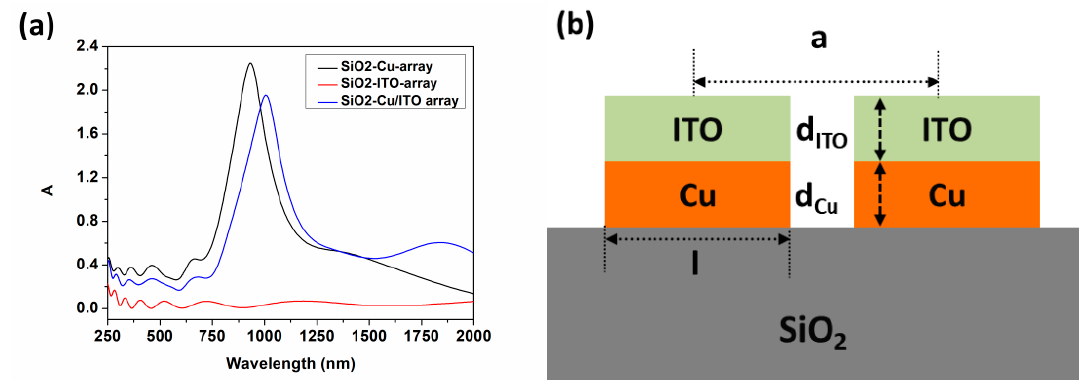
Figure 1. ( a ) The optical absorptions of the arrays; ( b ) The schematic diagram of the model.